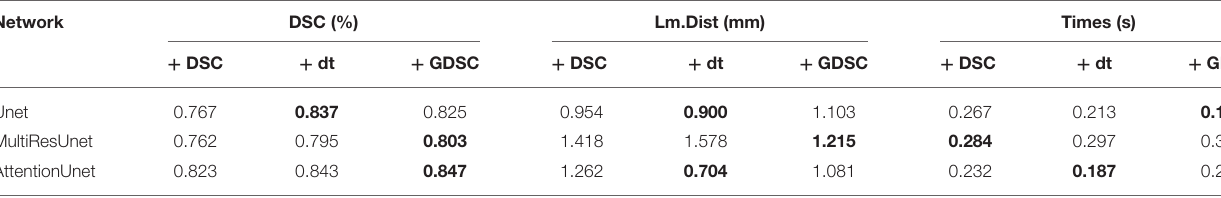
TABLE 3 | Registration performance of carotid artery under different loss functions. Network DSC (%)